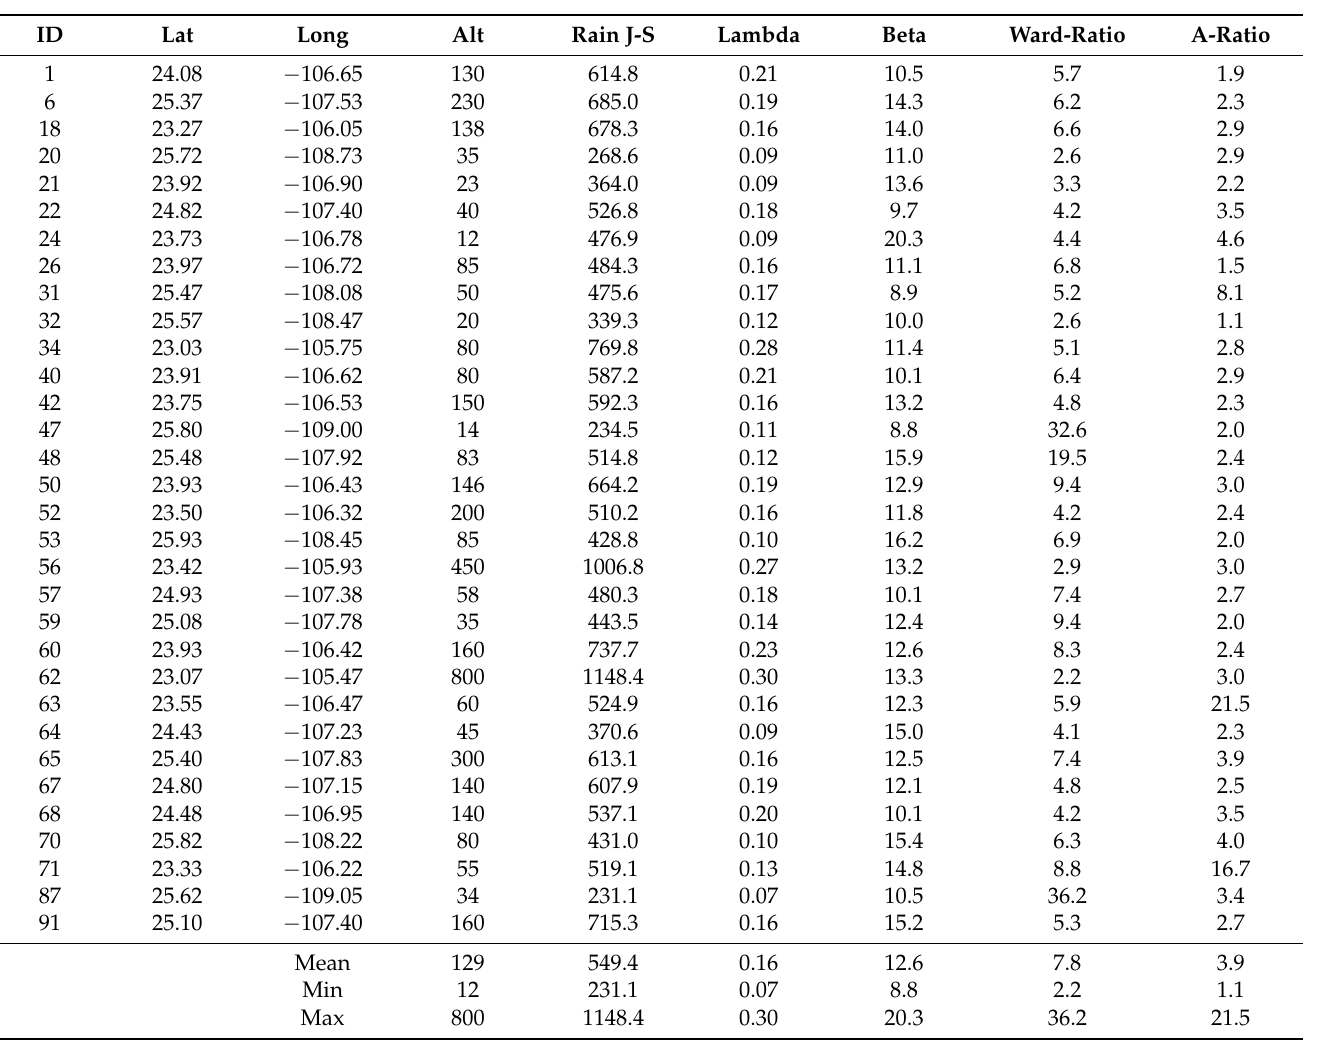
Table A2. Region II: Semi-arid zone, coastal desert with Hortonian runoff.